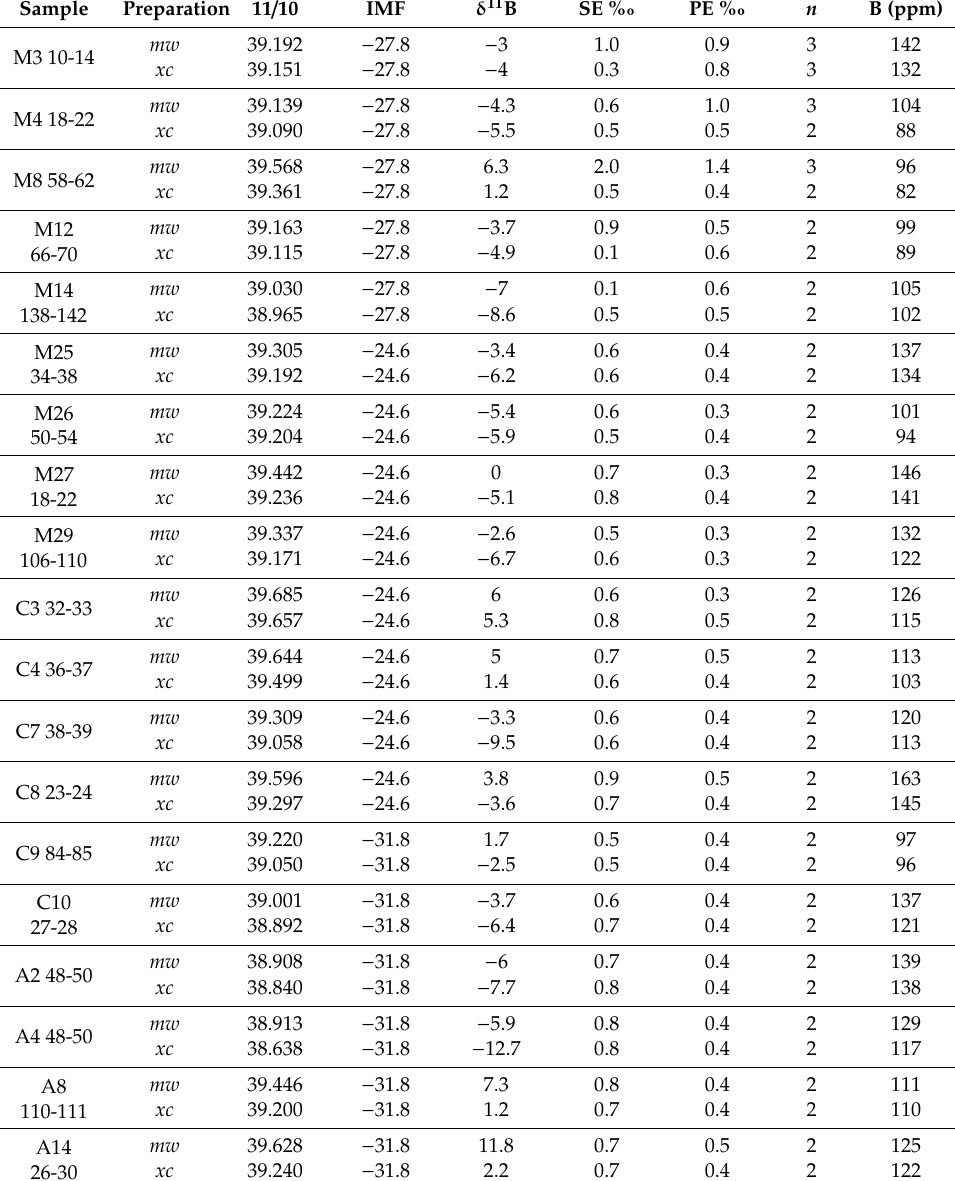
Table 5. Boron isotope analysis. mw , Mannitol washed samples; xc , NH 4 Cl exchanged samples. Standard IMt-1 is analyzed to determine IMF for each analytical session. This value is subtracted from the delta value. SE is standard error of the average. PE is predicted error, which is the best possible error based on counting